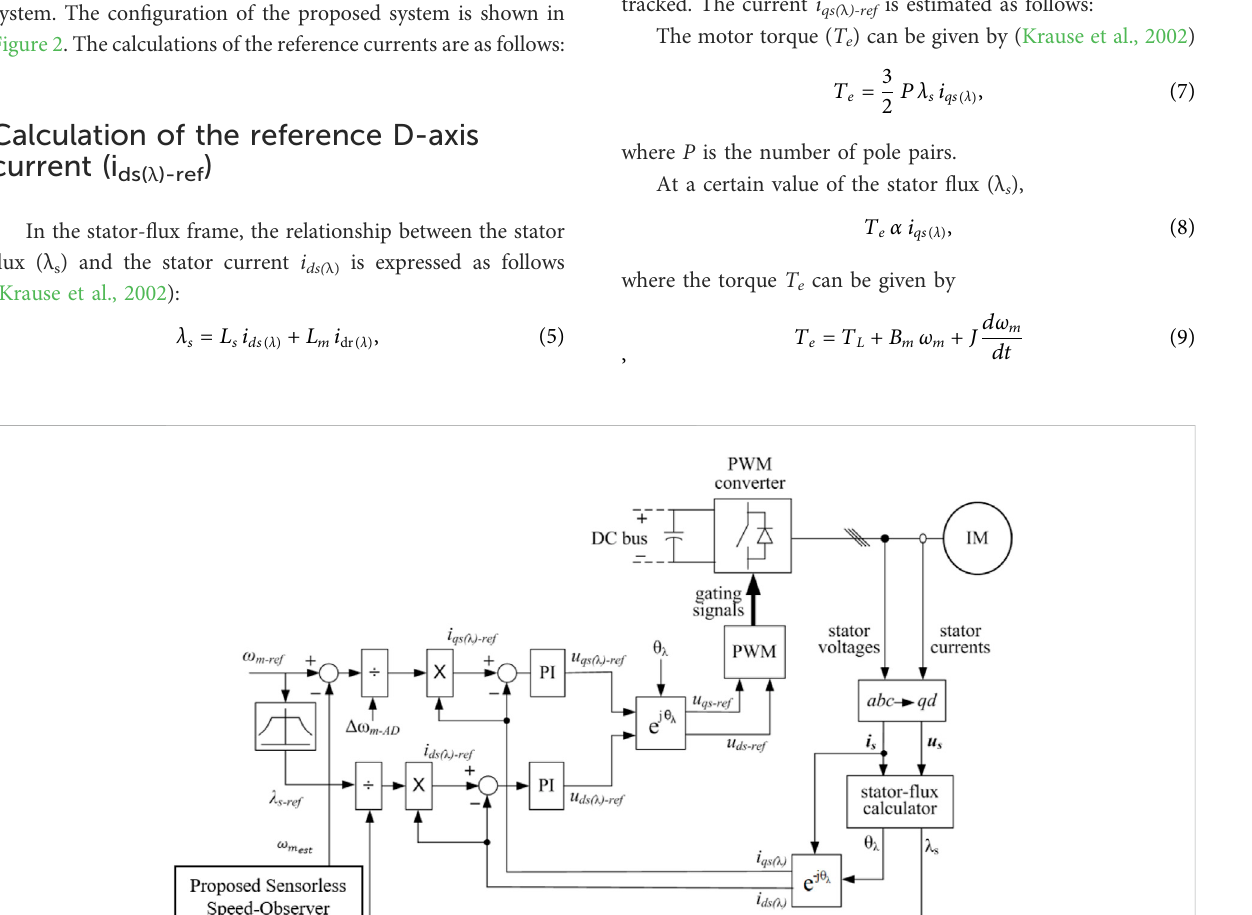
FIGURE 2 Proposed DSFOC